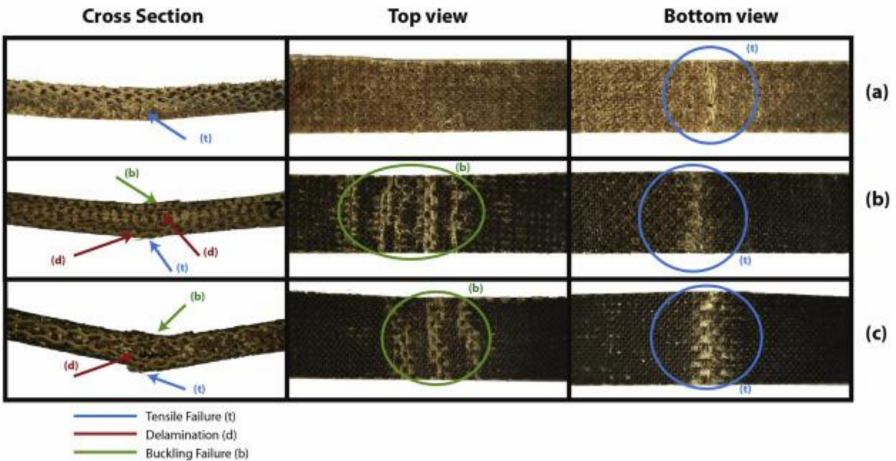
Figure 11. Jute-basalt reinforced hybrid composites including ( a ) jute fibre, ( b ) intercalate and ( c ) sandwich laminates [228]. Reproduced with permission,